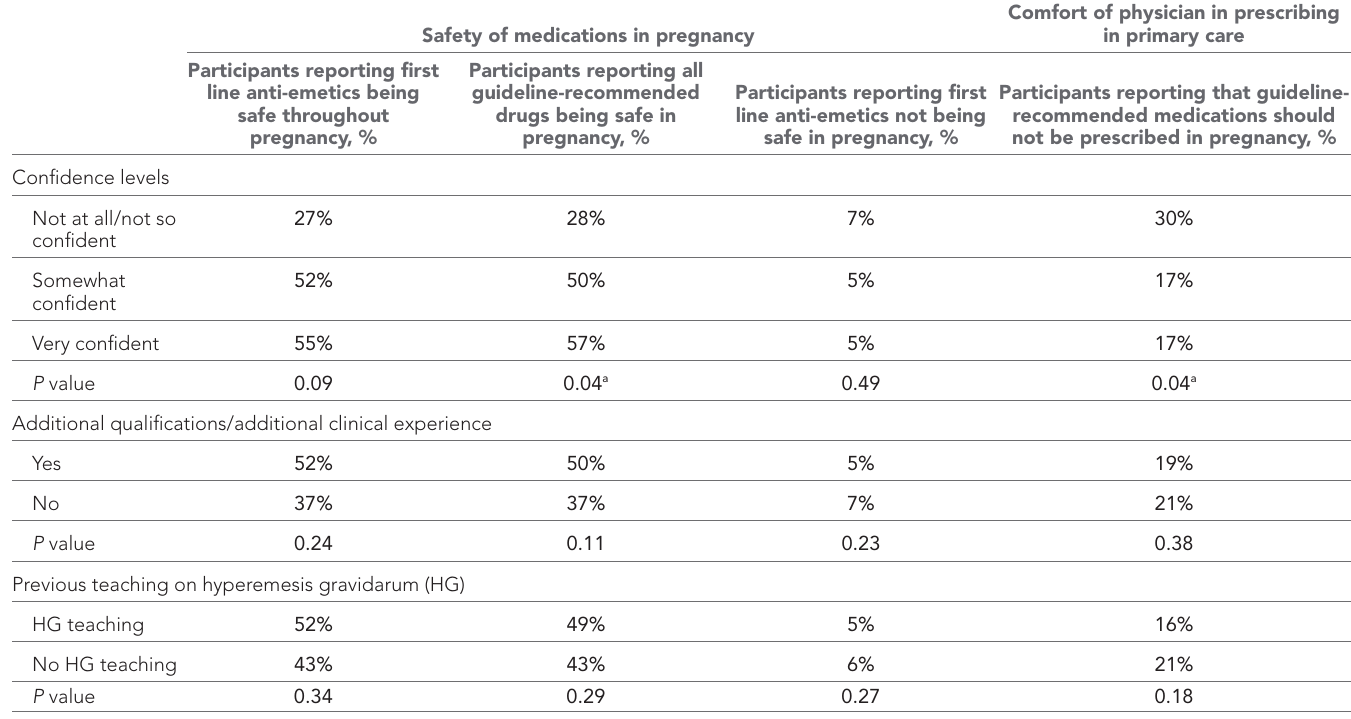
Table 2 Participant knowledge and comfort in prescribing first line anti- emetics and all drugs recommended in